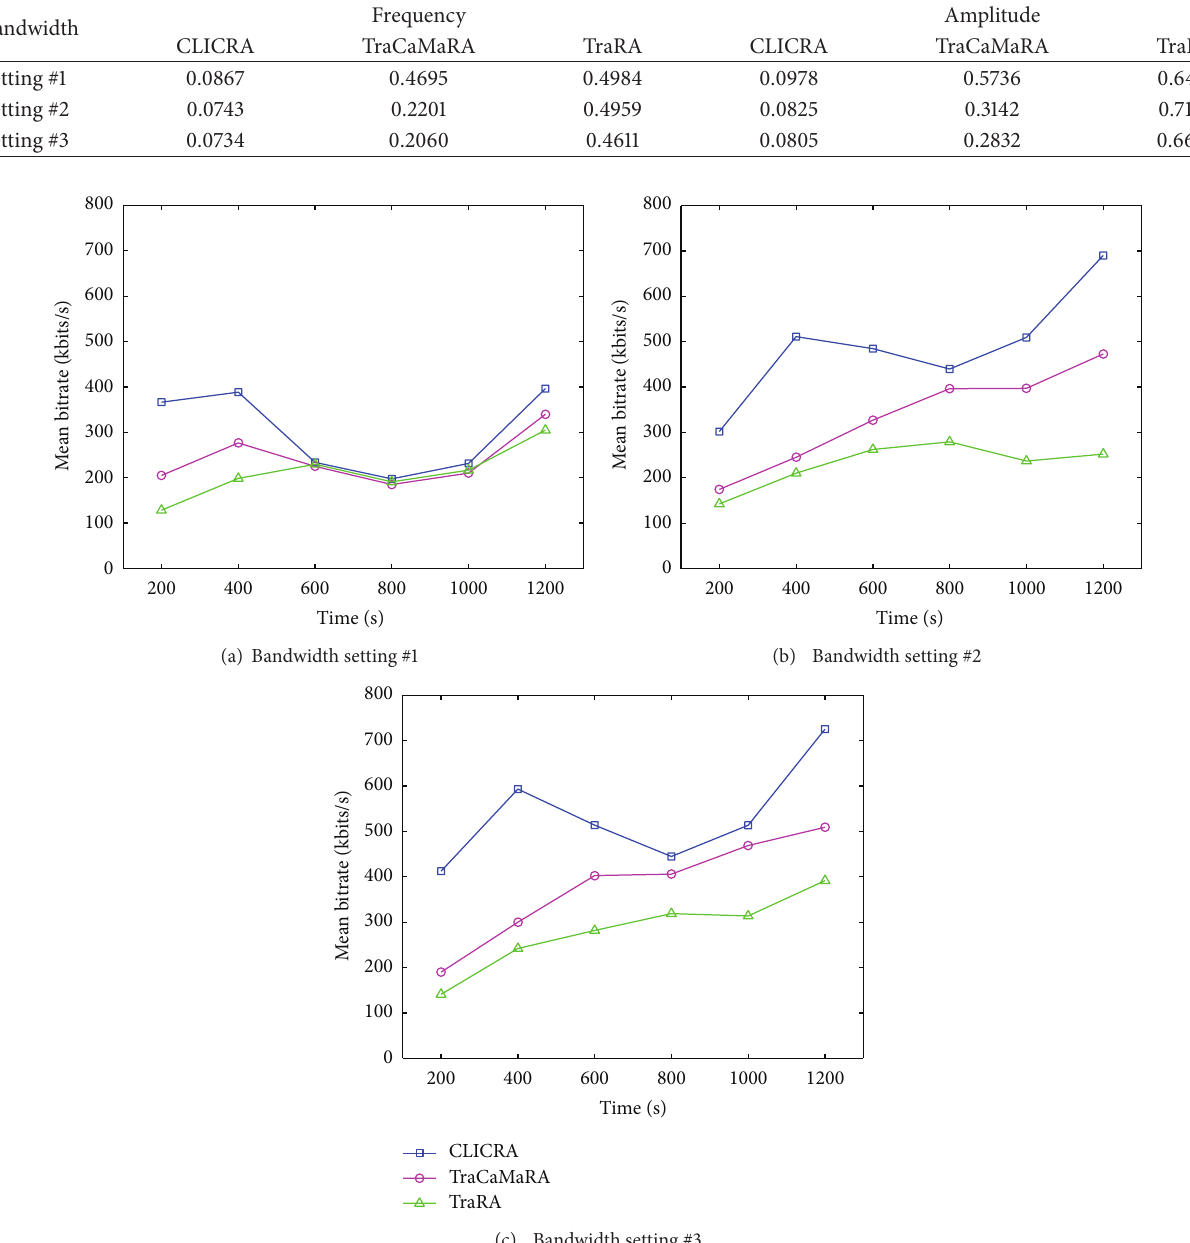
Figure 6: Received mean bitrate over simulation time for receive window